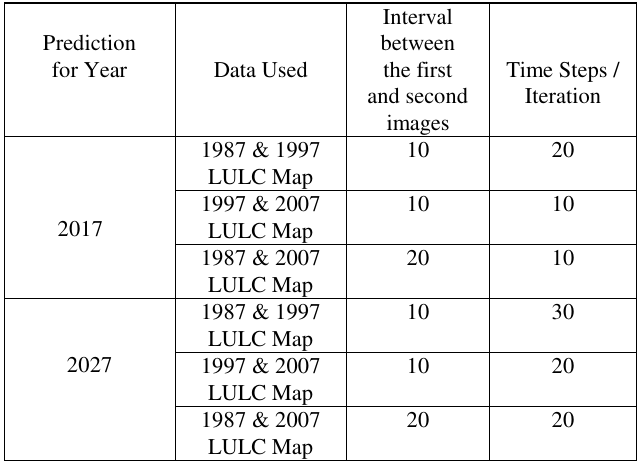
Table 2: Area statistics of LULC (land use land